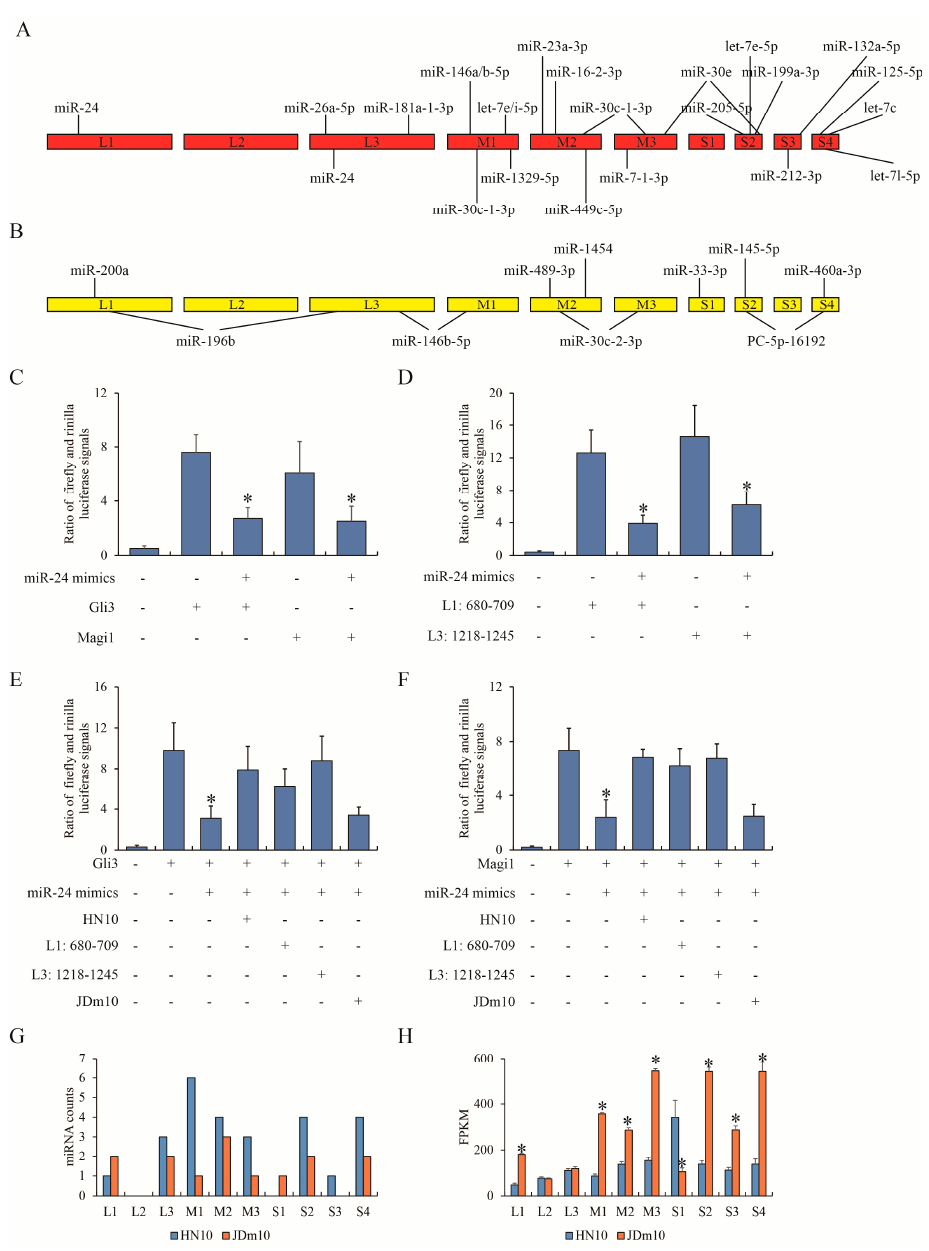
L3 (1218–1245) fragments of HN10 (Figure 5E), which was similar with Magi1 instead of Gli3 (Figure 5F). JDm10 infection failed to affect the fluorescence signals.